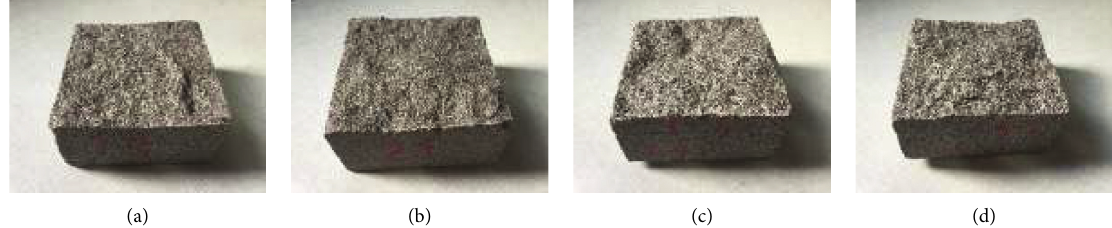
Figure 11: The 4 joint specimens used to evaluate roughness. (a) J-1. (b) J-2. (c) J-3. (d)